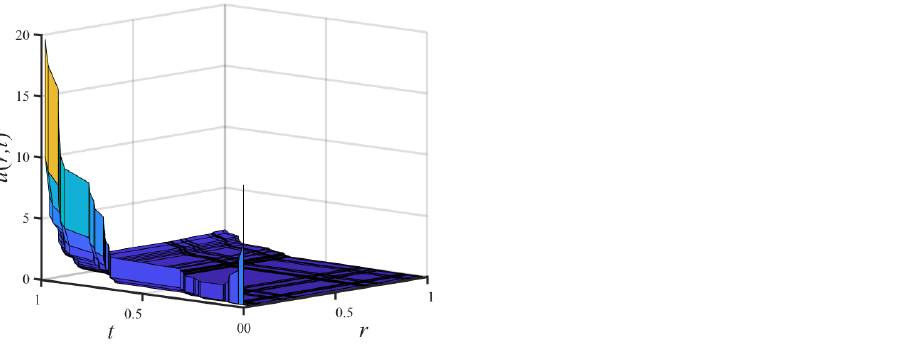
Figure 11. Nondifferentiable solution of P-wave displacement with nondifferentiable sink term for α = ln2/ ln3.